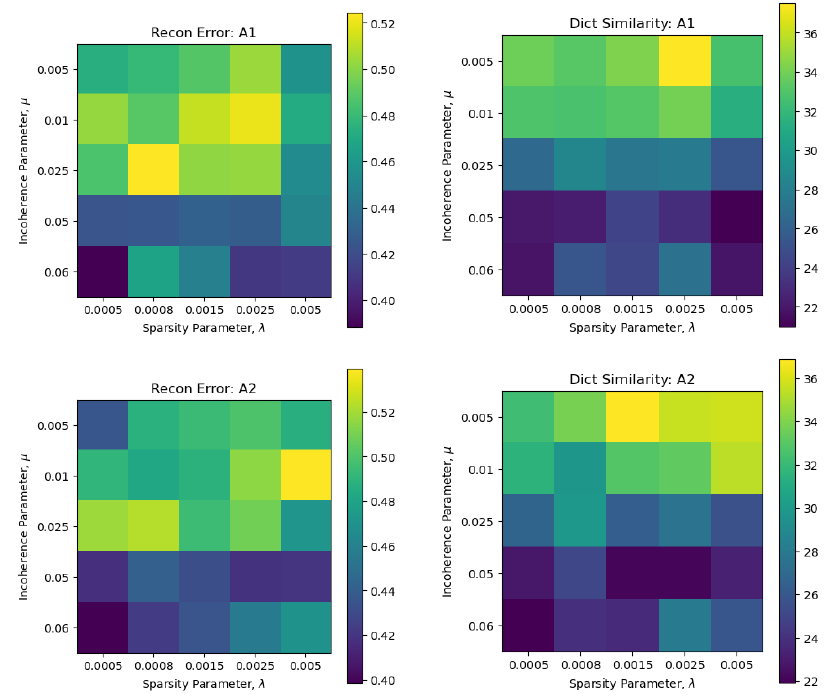
Figure 5. The effects of incoherence parameter µ and sparsity controlling parameter λ on reconstruc- tion error (14) and dictionary similarity metric (15) are shown on both algorithms performance using ETH dataset and w = 50